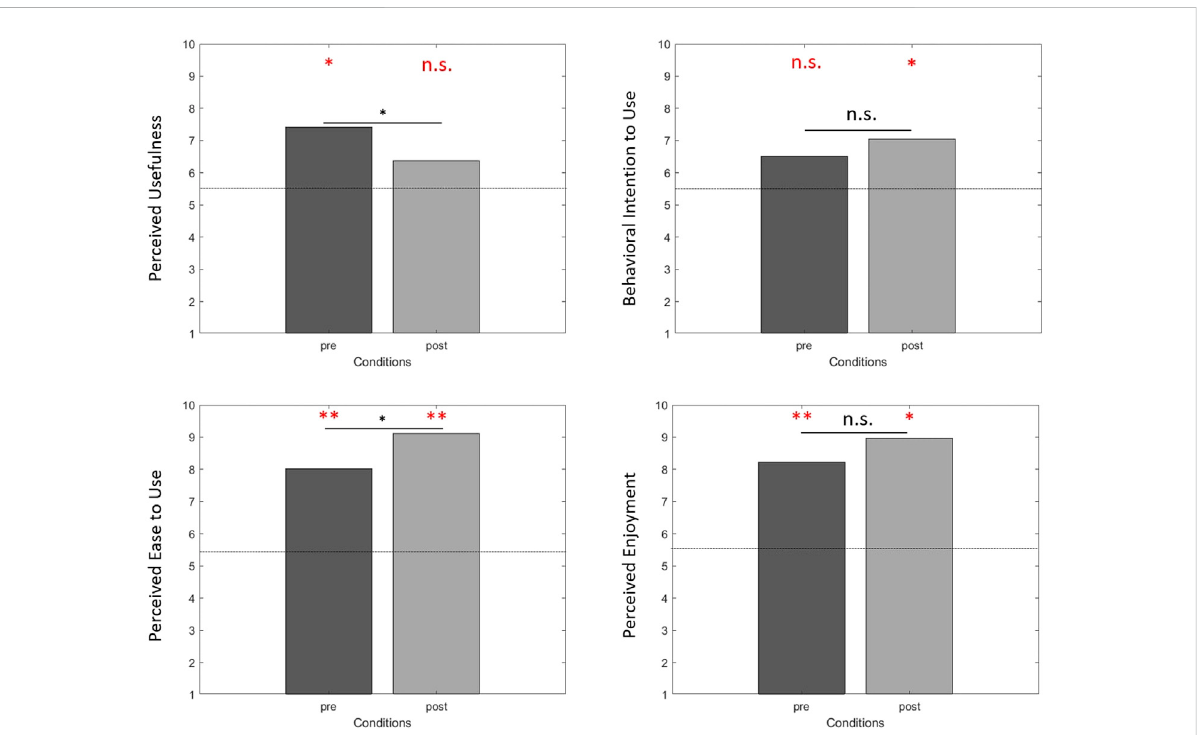
FIGURE 11 Acceptance of the virtual reality device before (pre) and after use (post). Analyses revealed that only PU after use ( p = 0.217) and BIU before use ( p = 0.184) were not different from the mean of the scale (i.e., dotted lines). Analyses showed differences between before and after use for PU ( p = 0.007) and PEU ( p = 0.033). n. s. no difference; * p < 0.05; ** p < 0.001. In red, compared with the mean of the scale. In black, between conditions